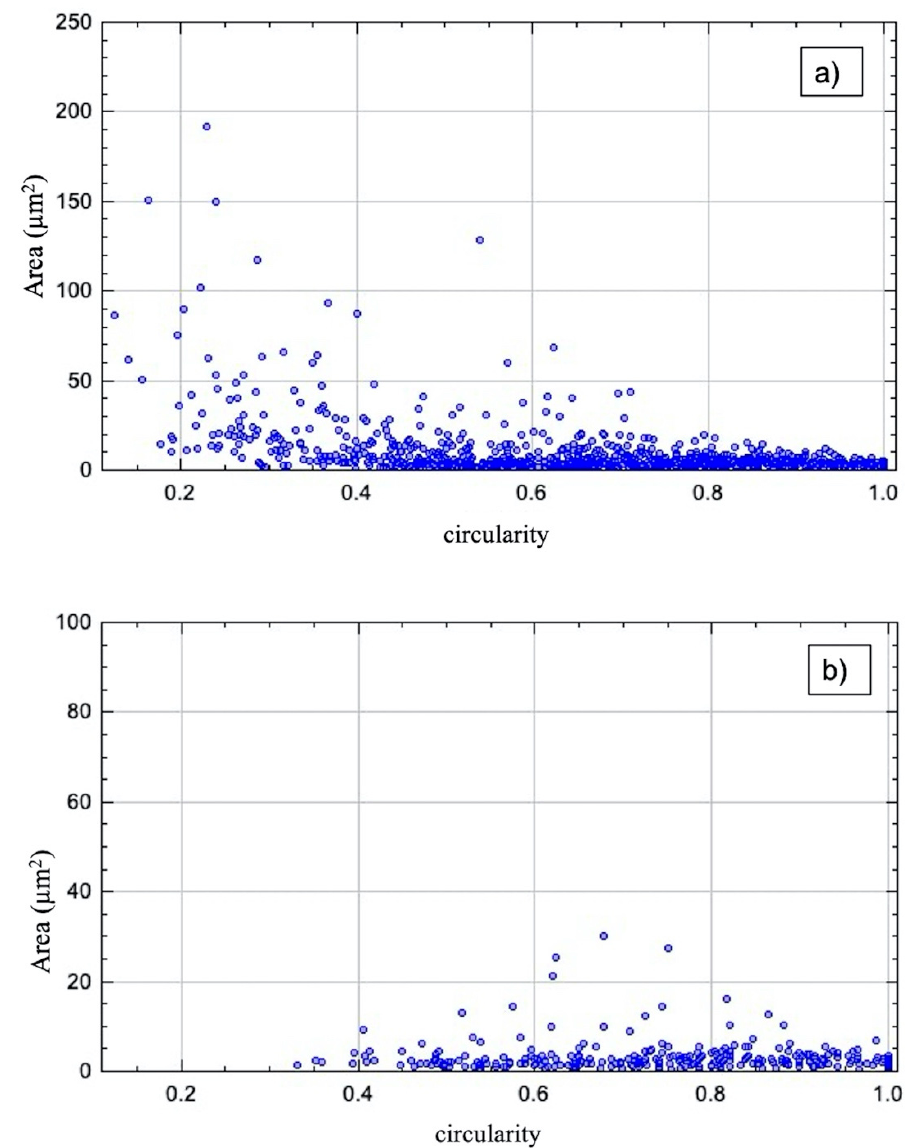
Figure 7. Comparison of ( a ) US and ( b ) TRM dispersion of 0.5 wt% CNToxi of the circularity in reliance to the area in µ m 2 . Area errors can be estimated through the grey value evaluation of the microscopic images in imageJ with about 1% of the values given. The two plots feature different scaling of the y -axis.